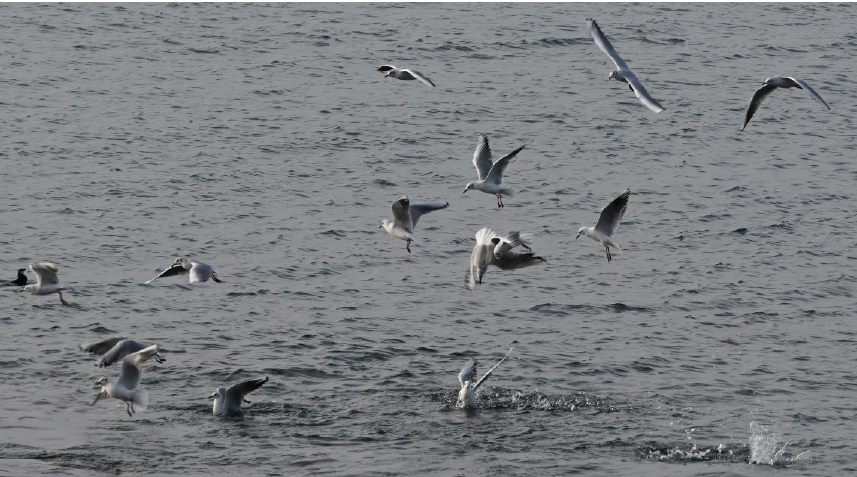
Figure 3. A group of seabirds preying on a fish shoal. All Chroicocephalus ridibundus plunge from different heights toward the fishes. Each bird plunges independently, and must avoid all others to catch its prey and get out of the water.